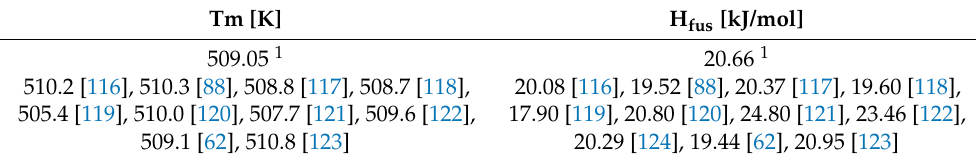
Table 3. The values of fusion data characterizing solid